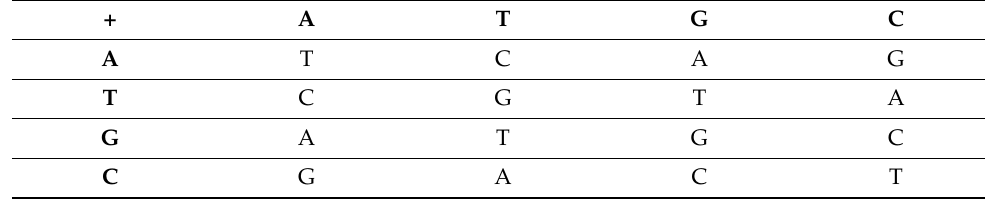
Table 2. Rule 3 for DNA addition.